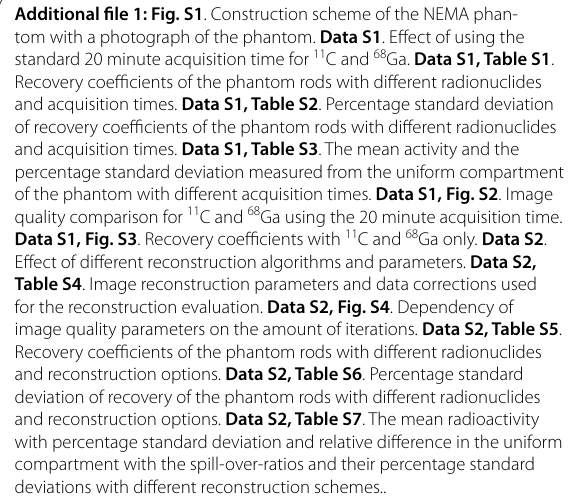
Table S4 . Image reconstruction parameters and data corrections used for the reconstruction evaluation. Data S2, Fig. S4 . Dependency of image quality parameters on the amount of iterations. Data S2, Table S5 . Recovery coefficients of the phantom rods with different radionuclides and reconstruction options. Data S2, Table S6 . Percentage standard deviation of recovery of the phantom rods with different radionuclides and reconstruction options. Data S2, Table S7 . The mean radioactivity with percentage standard deviation and relative difference in the uniform compartment with the spill-over-ratios and their percentage standard deviations with different reconstruction